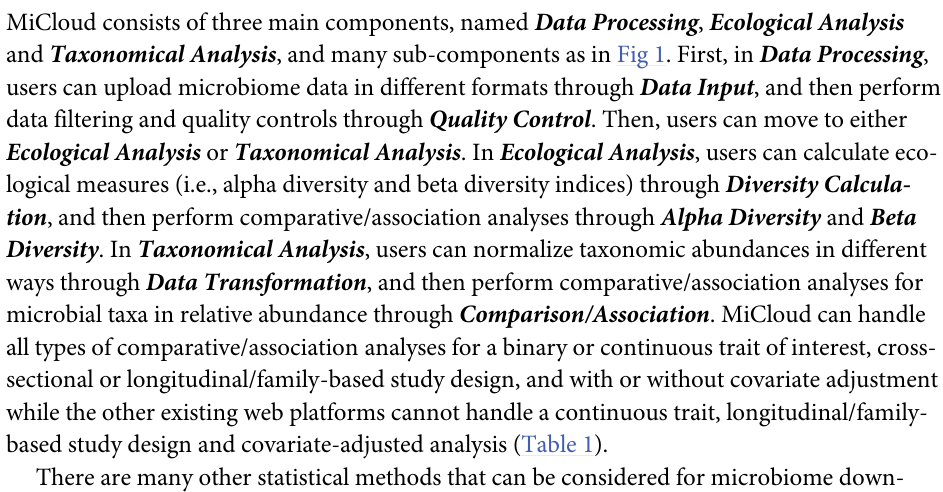
PLOS ONE | https://doi.org/10.1371/journal.pone.0272354 August 1,